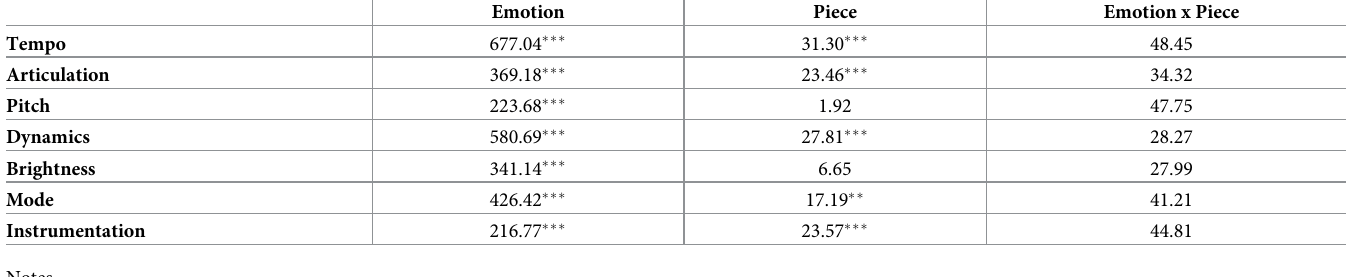
Table 1. The Chi-squared statistics ( χ 2 ) produced from likelihood ratio tests for separate G/LMM models of tempo, articulation, mode, pitch, dynamics, brightness, and instrumentation cues with and without the factors emotion, piece, and emotion x piece